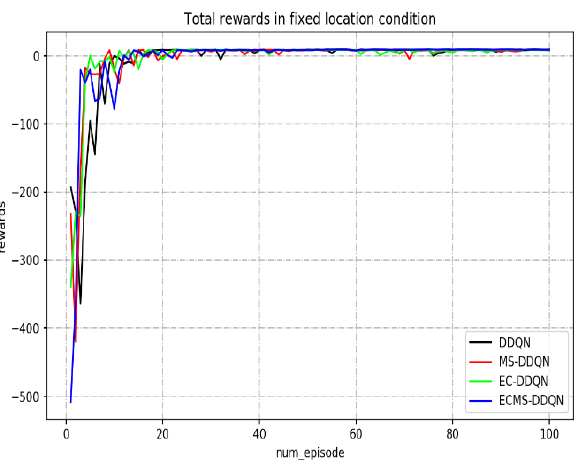
Figure 3. Return curve of four different algorithms in a fixed location scene.